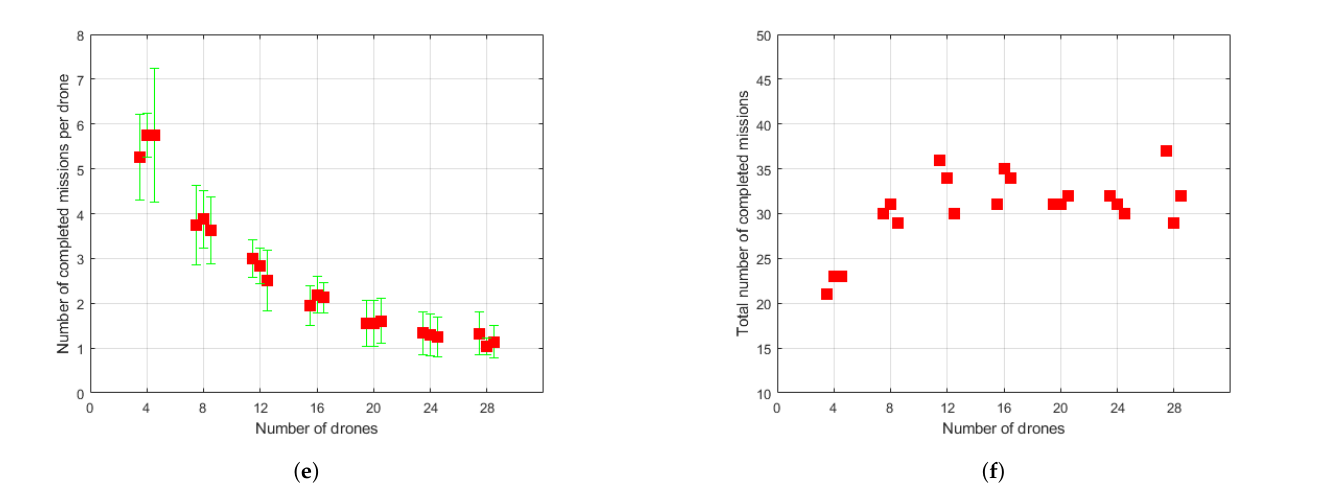
Figure 10. Statistical measures collected through simulations. Red squares represent mean values, while green ranges indicate mean absolute deviation. In the case of ( c , f ), red squares signify values directly collected from simulation. ( a ) Minimum distance found between vehicles in conflict. ( b ) Duration of conflicts. ( c ) Total number of conflicts. ( d ) Time per iteration. ( e ) Number of missions completed by each drone. ( f ) Total number of missions completed by the